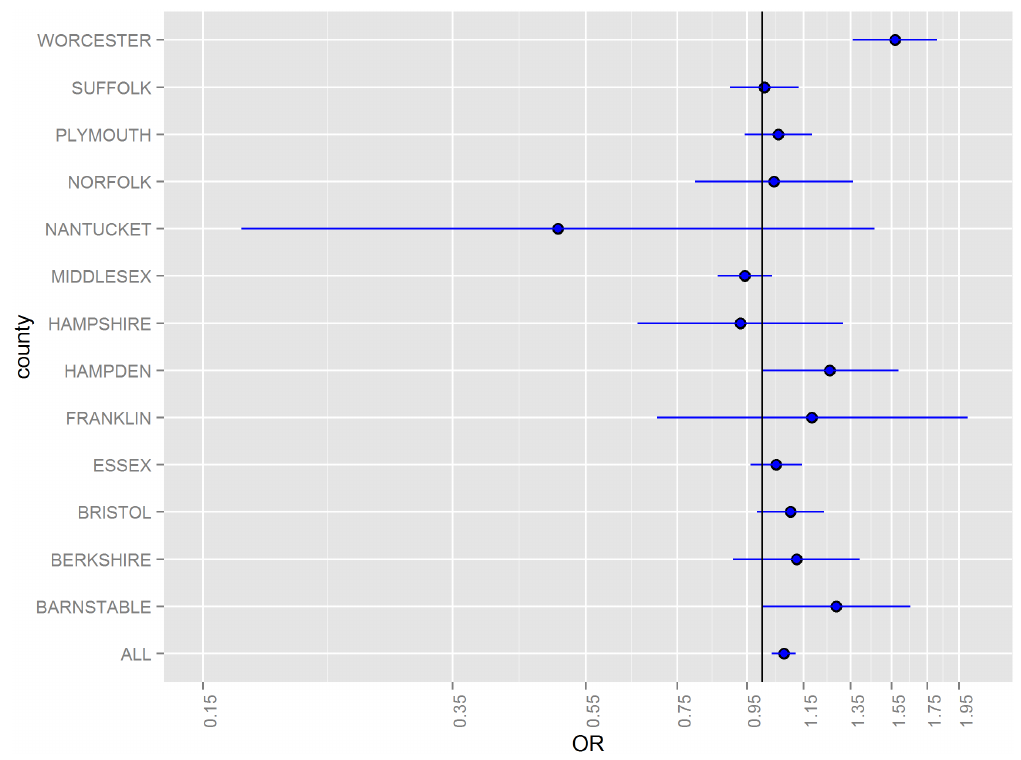
Figure 2. Odds ratios and 95% confidence intervals for emergency room visits for acute gastrointestinal symptoms in the 0–4 days following a flood, 2003–2007.